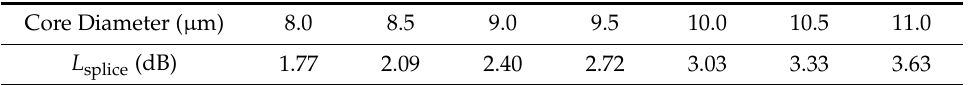
Table 2. The splice loss of designed MSF and commercially available SMF with di ff erent core diameters at 1550 nm.